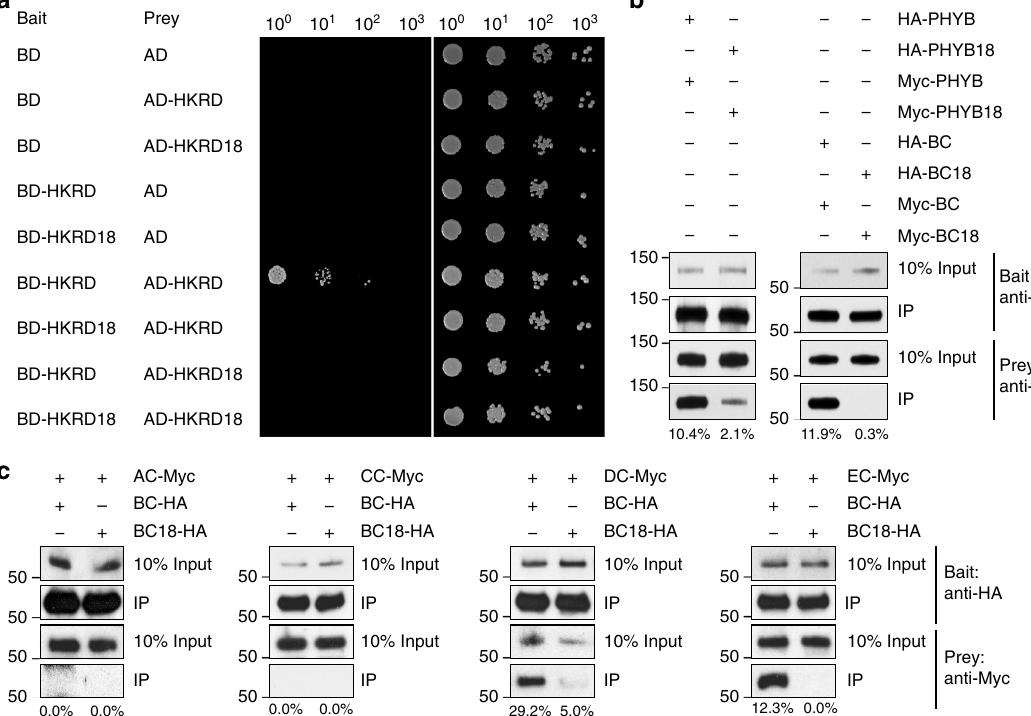
Fig. 7 D1040V disrupts homo- and heterodimerization of PHYB. a Yeast two-hybrid assays showing that the D1040V mutation disrupts the interaction between HKRD. Yeast cells carrying the indicated Bait and Prey constructs were grown on SD/-Trp/-Leu media either with (left) or without (right) AbA. b In vitro co-immunoprecipitation results showing that the D1040V mutation disrupts the interaction between the C-terminal domain of PHYB and attenuates the interaction between full-length PHYB. HA-tagged PHYB, PHYB18, PHYB ’ s C-terminal domain (BC), or PHYB18 ’ s C-terminal domain (BC18) was co-expressed with the corresponding Myc-tagged version using in vitro transcription/translation and subsequently immunoprecipitated using anti-HA af fi nity matrix. Bait and prey proteins were detected by immunoblots using anti-HA and anti-Myc antibodies, respectively. The relative amounts of immunoprecipitated Myc-tagged PHYB fragments are shown below the immunoblots. c In vitro co-immunoprecipitation results showing that the D1040V mutation in the C-terminal module of PHYB reduces its interaction with the C-terminal modules of PHYD and PHYE. HA-tagged C-terminal module of PHYB (BC) or PHYB18 (BC18) was in vitro co-translated with Myc-tagged C-terminal module of PHYA (AC), PHYC (CC), PHYD (DC) or PHYE (EC) and immunoprecipitated using anti-HA af fi nity matrix. Bait and prey proteins were detected by immunoblots using anti-HA and anti-Myc